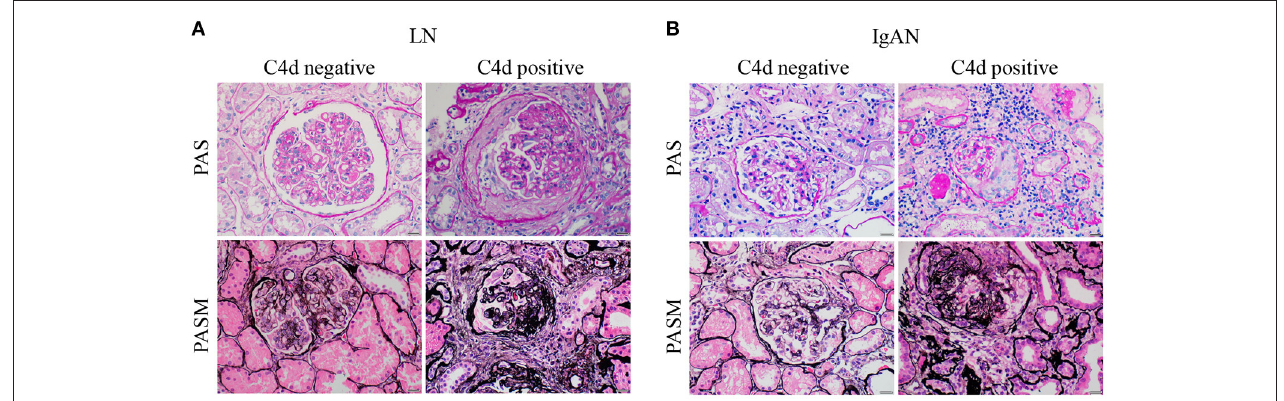
FIGURE 3 | Representative periodic acid schiff (PAS) and periodic acid-silver methenamine (PASM) images of LN and IgAN patients with negative or positive renal C4d deposition. (A) The representative PAS (top panels) and PASM (bottom panels) images of LN patients with (right panels) or without (left panels) renal C4d deposition. (B) The representative PAS (top panels) and PASM (bottom panels) images of IgAN patients with (right panels) or without (left panels) renal C4d deposition. Scale bars: 20 µ m. LN, lupus nephritis; IgAN, IgA nephropathy; PAS, Periodic Acid Schiff; PASM, periodic acid-silver methenamine.